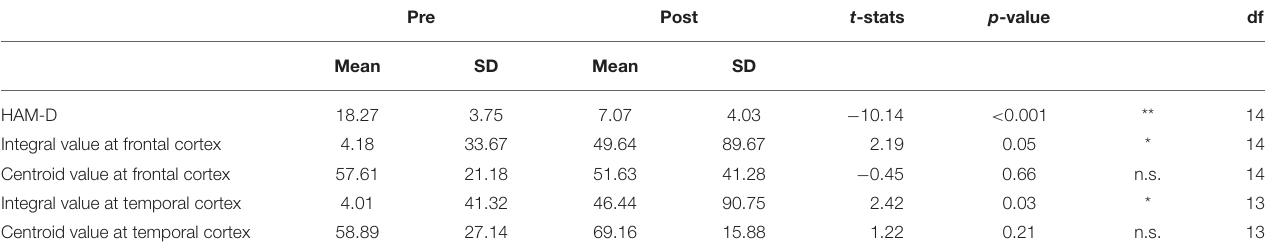
TABLE 2 | The difference between pre- and post-rTMS treatment regarding the severity of depression (HAM-D) and fNIRS assessment. Pre Post